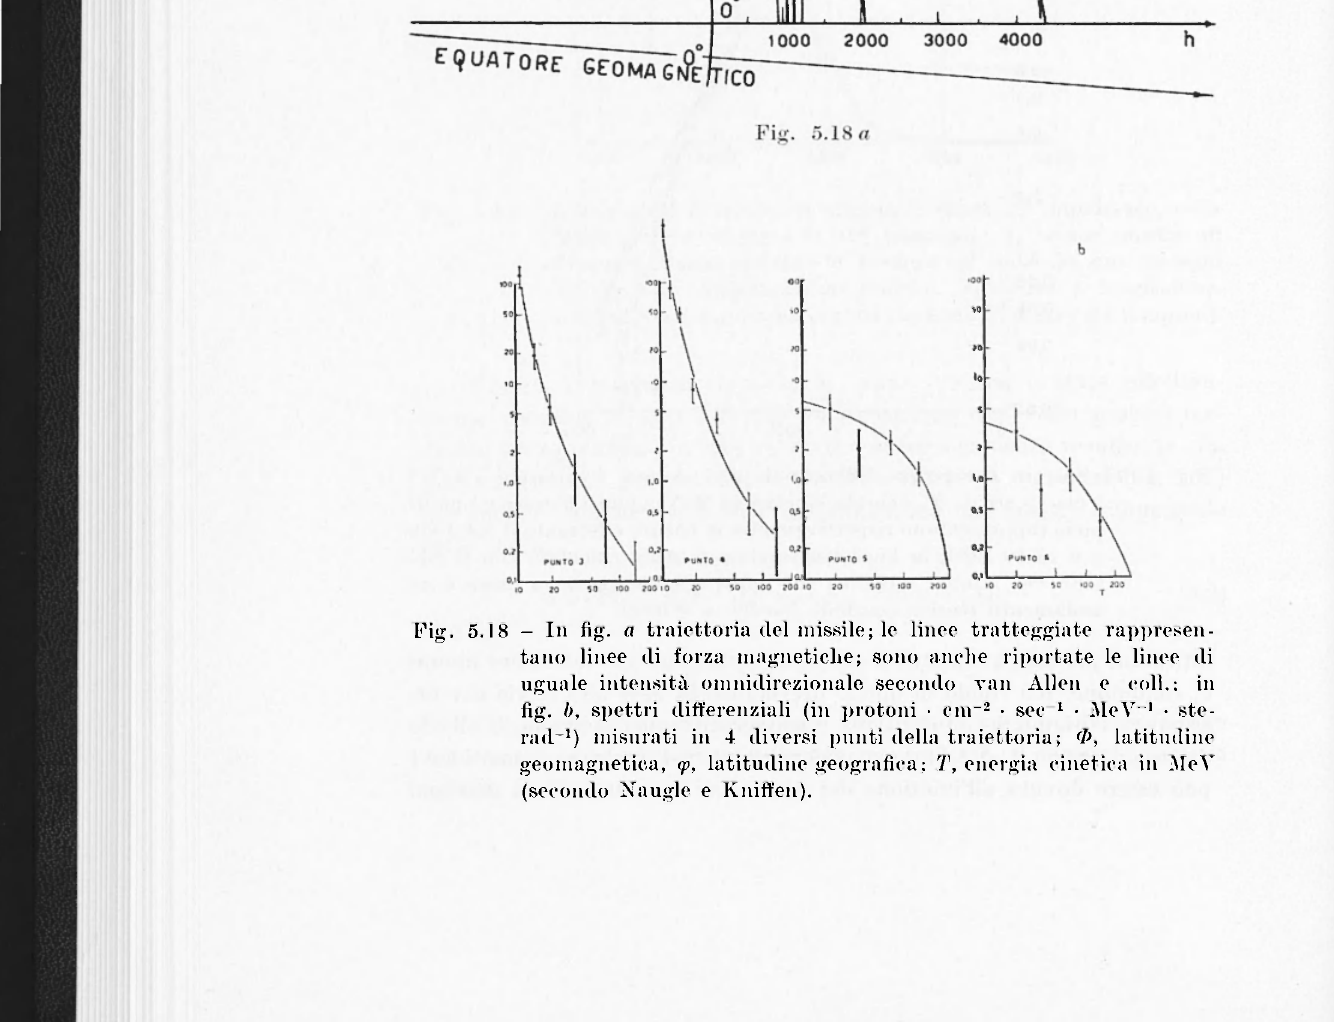
Fig. 5.18 - In fig. a traiettoria del missile; le linee tratteggiate rappresen- tano linee di forza magnetiche; sono anche riportate le linee di uguale intensità omnidirezionale secondo van Alien e coli.; in fig. b, spettri differenziali (in protoni • c n r ! • sec 1 • MeV ' • ste- rad" 1 ) misurati in 4 diversi punti della traiettoria; 0, latitudine geomagnetica, <p, latitudine geografica; T, energia cinetica in MeV (secondo Naugle e